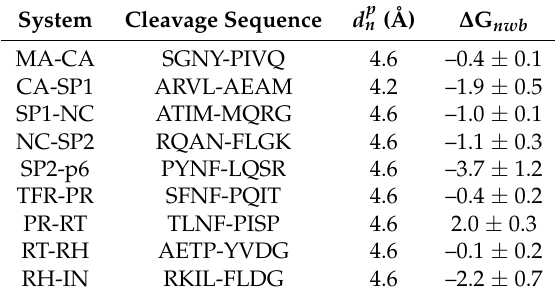
Figure 2. Normalized density distributions ( ρ ( d n ) ) of the nearest water distance ( d n ) to the catalytic center across all enzyme-bound substrate systems. The bound-unbound partition distance ( d p n ) is shown (dashed black line). Table 1. Free energies of nucleophilic water binding ( ∆ G nwb ) in the enzyme-bound substrate complexes based on assigned partition thresholds, d p n . All energies are in